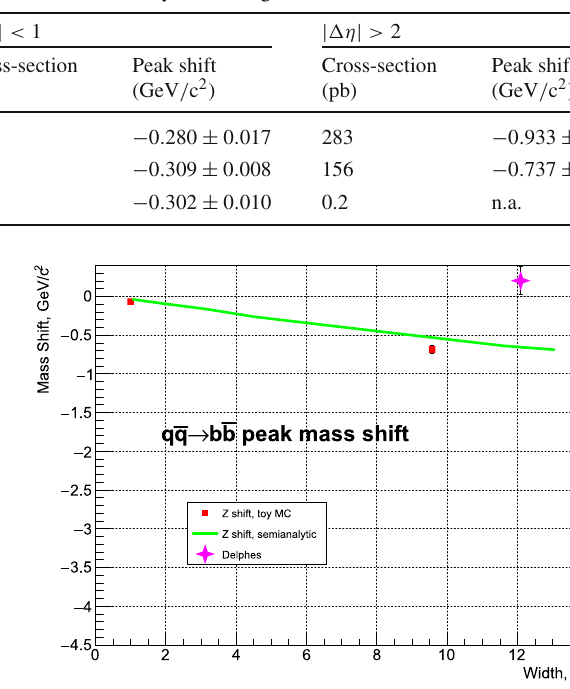
symbols the effect of gluon radiation or Delphes simulation as dis- cussed in the text. The continuous lines show the impact of a numerical smearing applied to the fitted interference